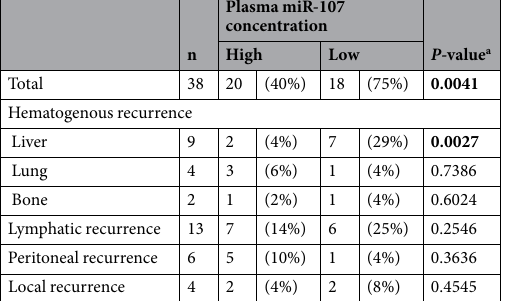
Table 2. Association between plasma miR-107 levels and types of recurrence in PCa patients with pancreatectomy. a Chi-square test. NOTE: significant values are in